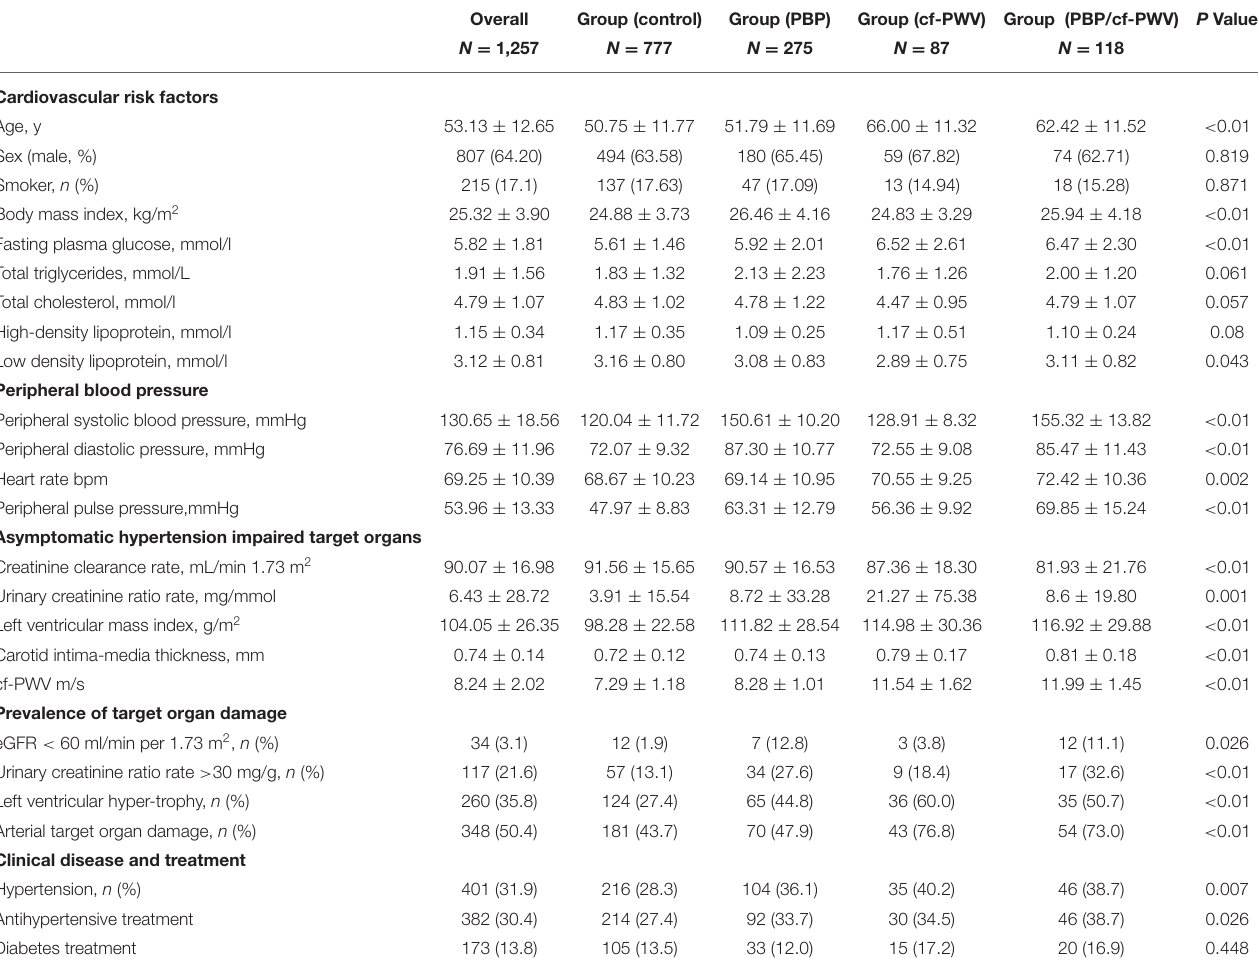
TABLE 2 | Demographic characteristics of groups based on peripheral blood pressure and cf-PWV. Overall Group (control) Group (PBP) Group (cf-PWV) Group (PBP/cf-PWV) P Value N =